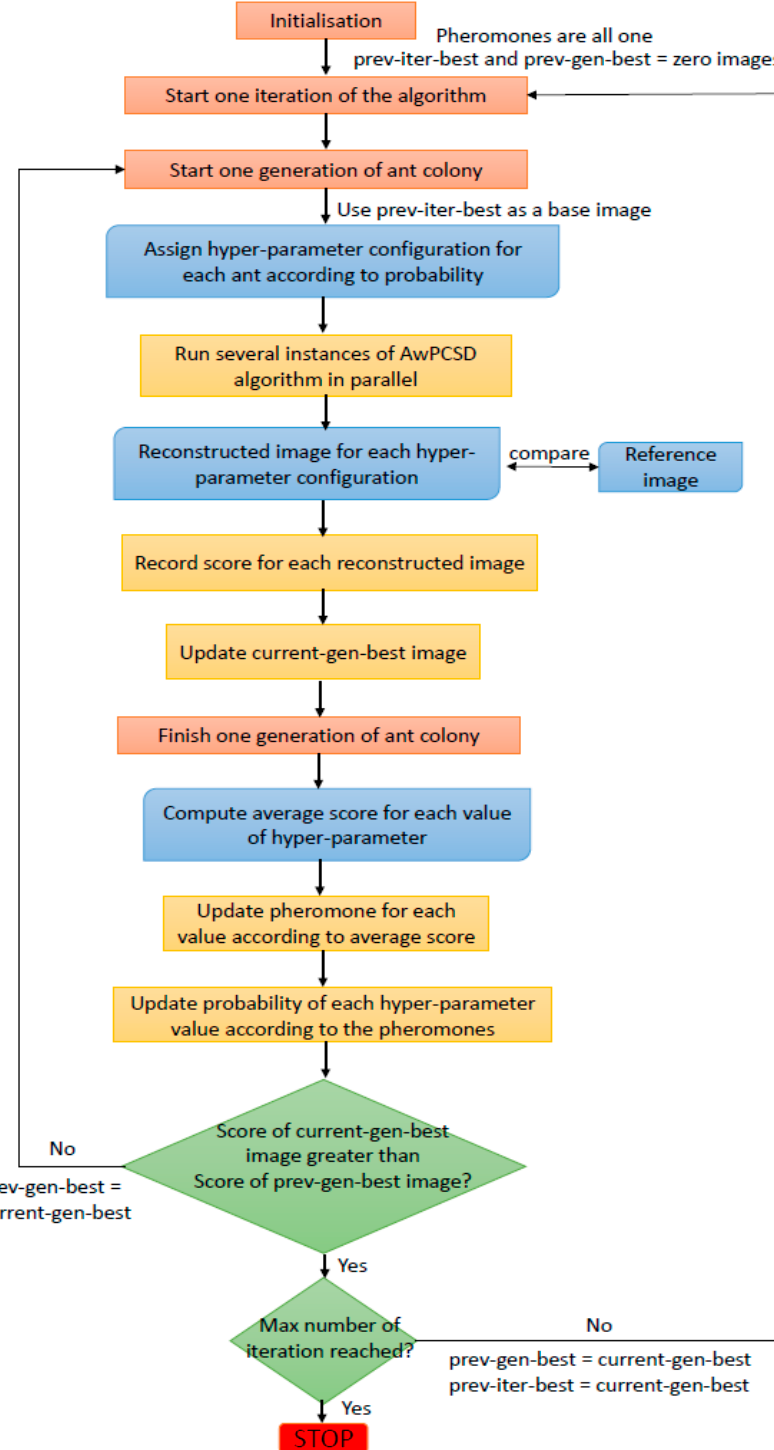
Figure 1. The framework of the computer-aided hyperparameter tuning approach using the ACO algorithm.